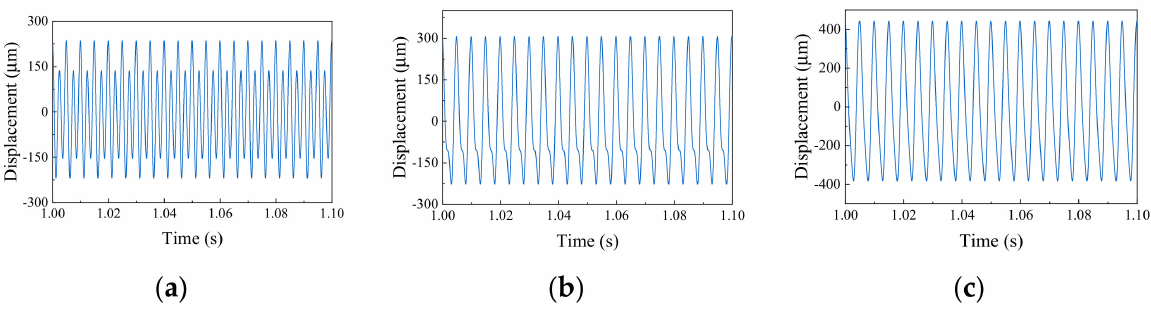
Figure 5. Imbalanced and misaligned coupling faults: ( a ) value of imbalance 20 × 10 − 5 kg · m;